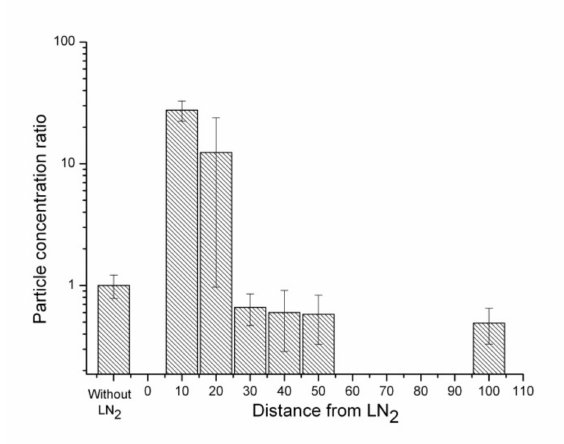
Figure 4. Concentration ratios of particles of size 5 µ m at distances of 10, 20, 30, 40, 50, and 100 cm from the LN 2